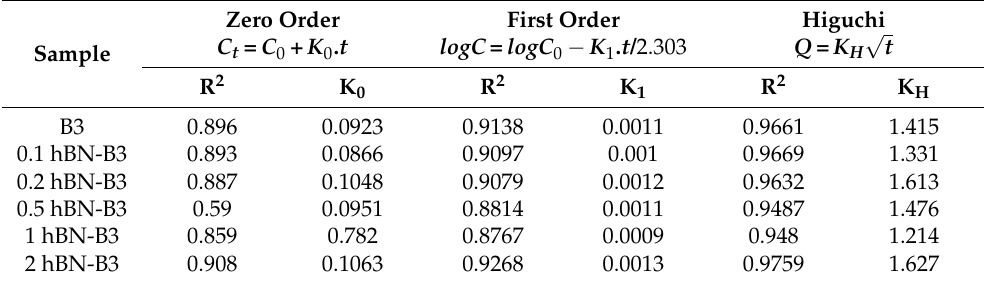
Figure 9. ( a ) 5-FU adsorption curve; ( b ) cumulative 5-FU release curve for studied bioactive glass scaffolds. Table 2. 5-FU release kinetics model parameters. K 0 , K 1 , and K H are zero order, first order, and Higuchi model rate constants. T is time, and C 0 is the initial concentration of the